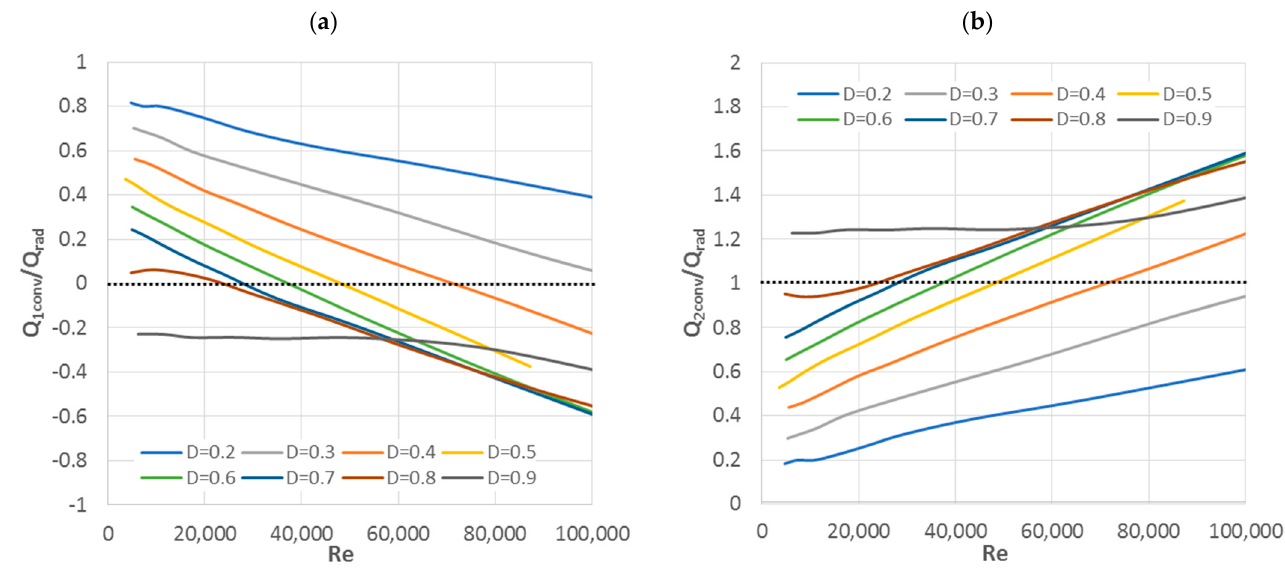
Figure 7. Fractions of convective heat fluxes on the insert surface in relation to the heat flux delivered to the insert by radiation Q rad . ( a ) Q 1conv —heat flux on the outer surface of the insert, ( b ) Q 2conv —heat flux on the inner surface of the insert.